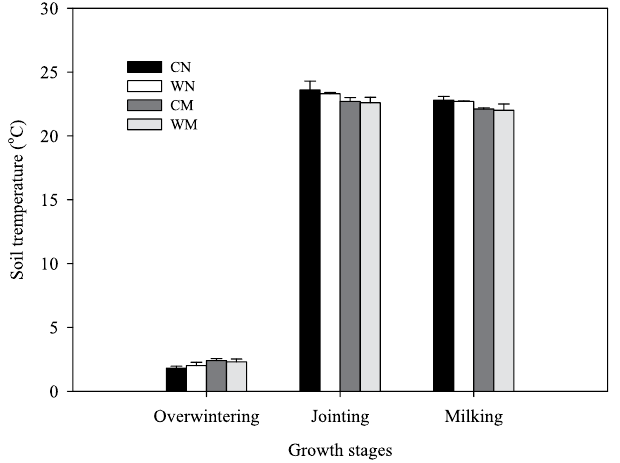
Figure 2. Soil temperature at the depth of 10 cm in 2013–2014 winter wheat growing season. WN represent wide-precision planting with non-mulching, CN represent conventional-cultivation planting with non- mulching, WM represent wide-precision planting with straw mulching, and CM represent conventional- cultivation planting with straw mulching, respectively. Vertical bars are standard errors.